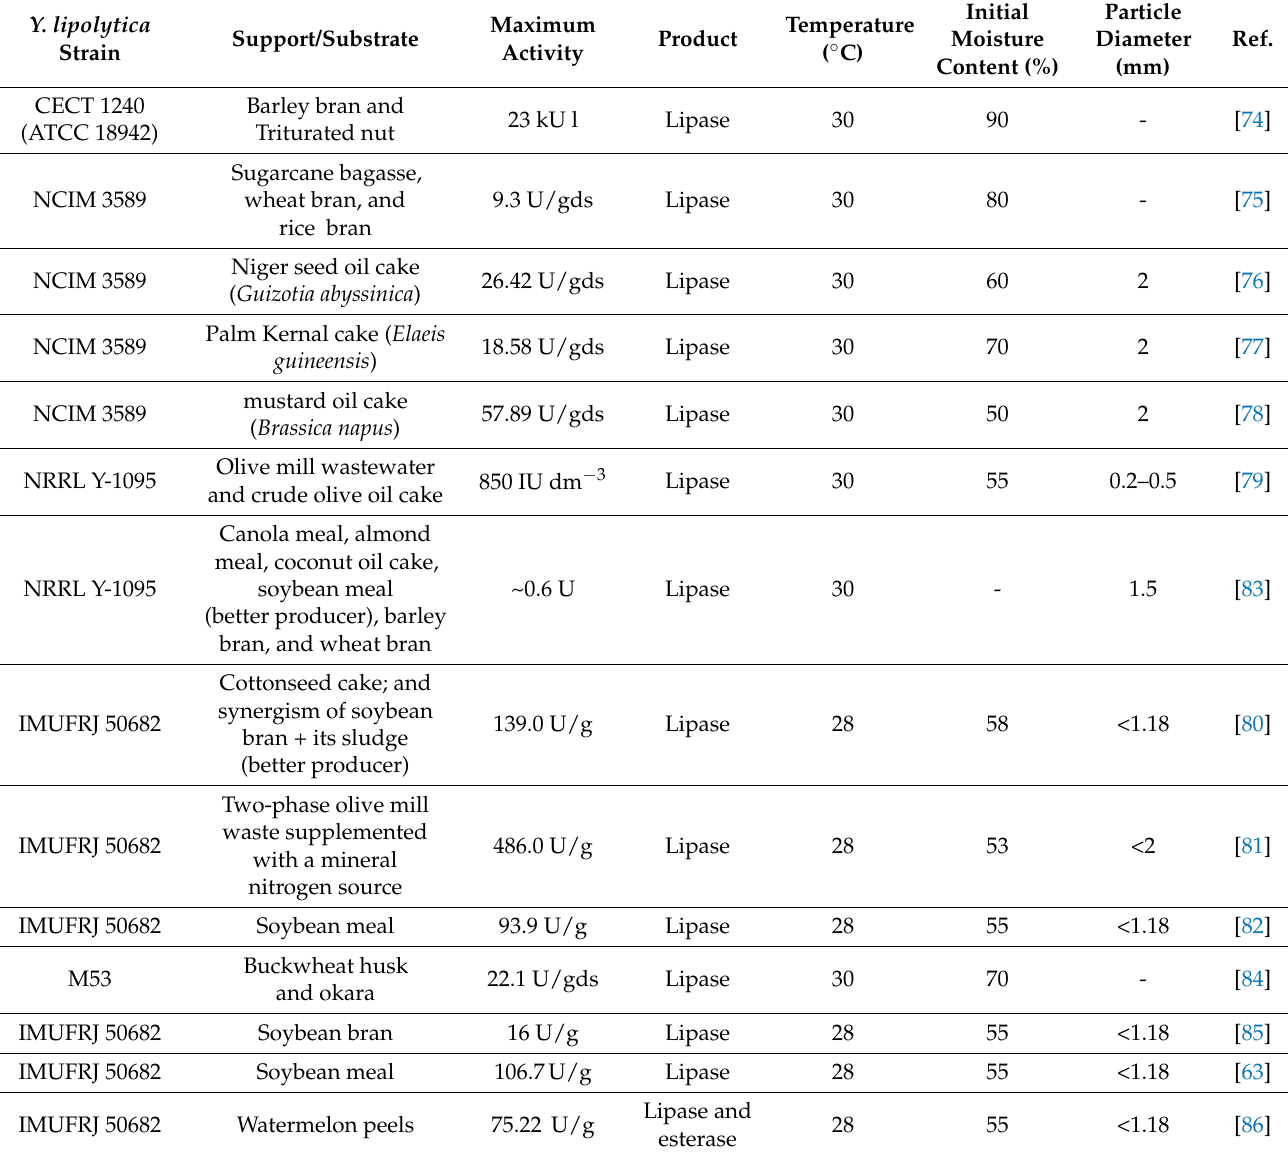
Table 3. Main process conditions used for solid-state cultivation of Y. lipolytica . Y.